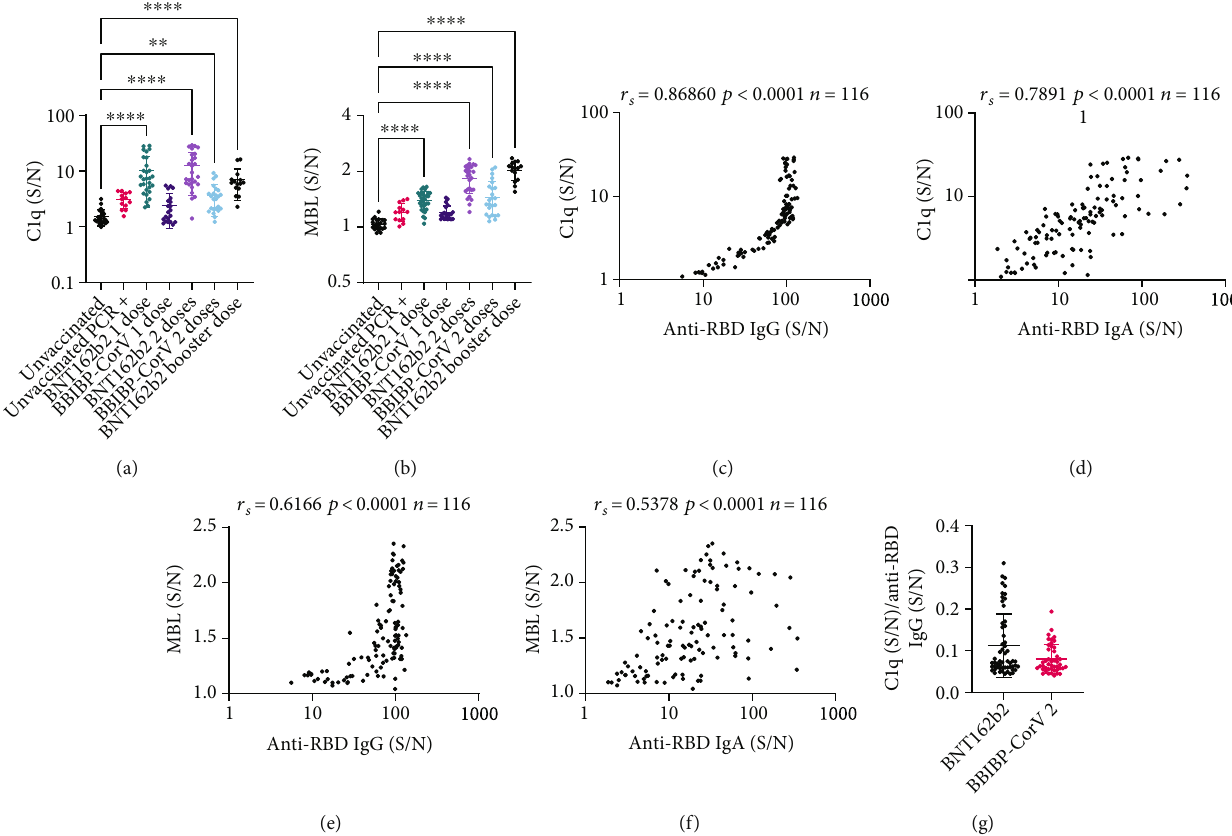
Figure 2: Measurement of C1q and MBL binding and their correlation to immunoglobulins. Participants were divided by their vaccination status, type of vaccine, and dose of vaccine. Serum samples were incubated with RBD-coated plates; bound C1q was subsequently measured using an indirect sandwich immunoassay. (S/N) represents the chemiluminescence signal generated from wells incubated with 1% serum divided by the signal in control wells incubated with PBST. (a) Represents bound C1q levels while (b) represents bound MBL levels. (c) A log-log scatter plot that correlates C1q to anti-RBD IgG and (d) a log-log scatter plot that correlates C1q to anti-RBD IgA levels in all vaccinated participants. (e) and (f) are scatter plots that correlate MBL to anti-RBD IgG and IgA levels, respectively, in all vaccinated ), P value, and the number of participants ( n ) are displayed on the plot. (g) Individual participants. Spearman ’ s correlation coe ffi cient ( r s values of C1q (S/N) per anti-RBD IgG (S/N) in each participant were calculated and displayed in a scatter plot for the two types of vaccines. In scatter plots, each circle represents one participant, bold horizontal lines represent the mean of each group, while whiskers represent the standard deviation. Dunn ’ s multiple comparisons statistical test following Kruskal – Wallis test was used to compare various groups to the unvaccinated group. Only signi fi cant pairwise comparisons are displayed, ∗∗ P ≤ 0 : 01 , ∗∗∗∗ P ≤ 0 : 0001